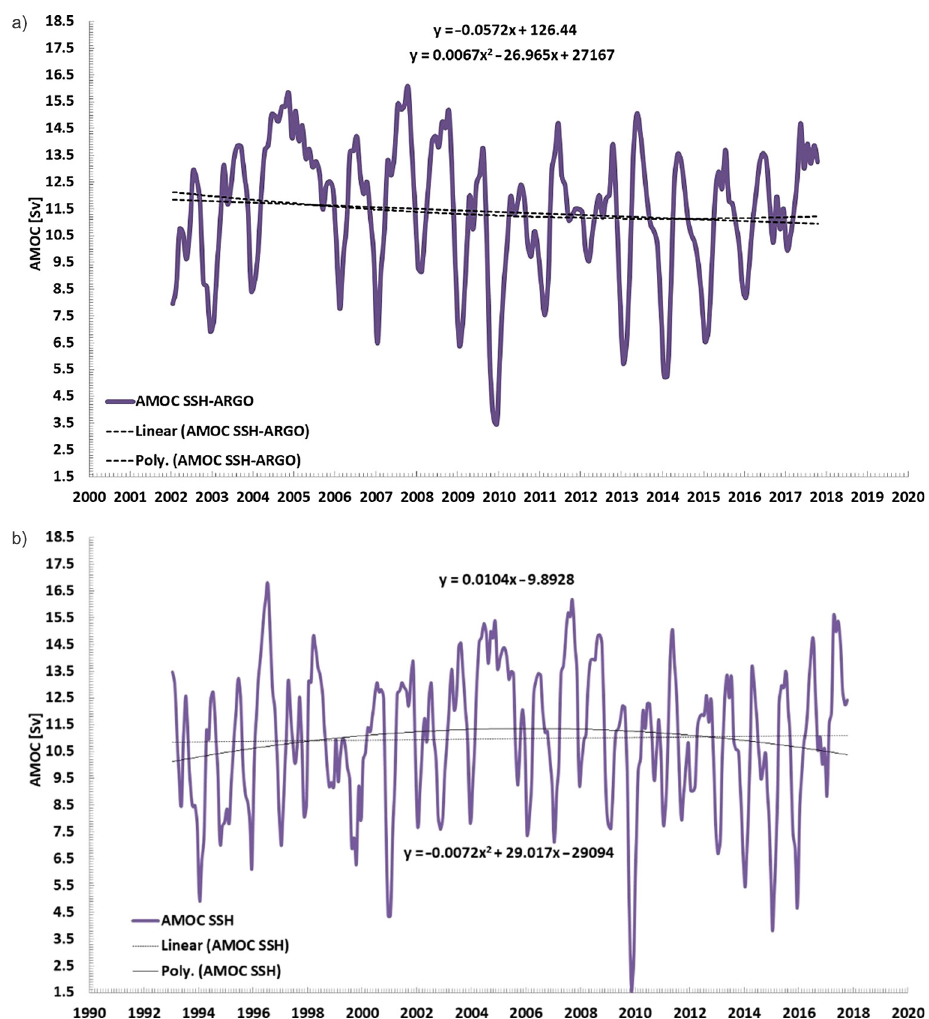
Fig. 2. The Atlantic Meridional Overturning Circulation time series: a) AMOC SSH+ARGO since the year 2002, b) AMOC SSH since the year 1993. The time series represent three-month running